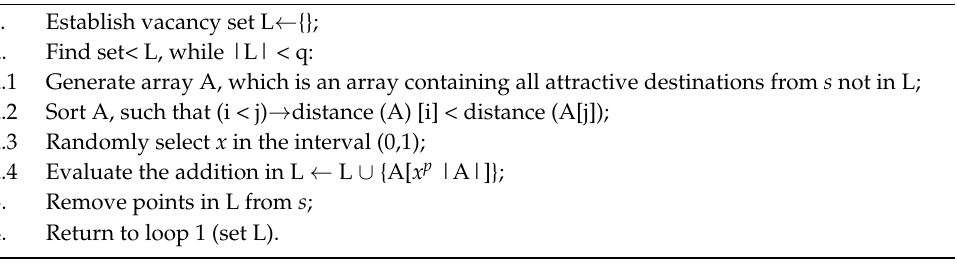
Algorithm 3 . Worst removal algorithm.